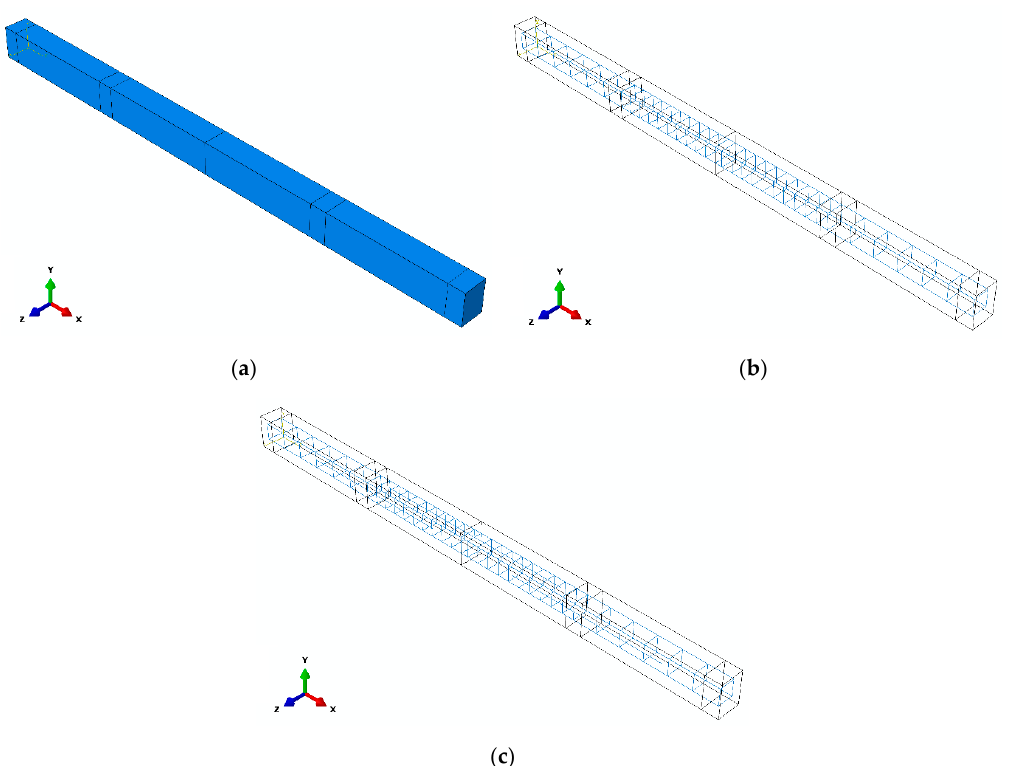
Figure 8. Model geometry in the software package Abaqus: ( a ) concrete beam; ( b ) reinforcement of Beams B − 1 and B − 2; ( c ) reinforcement of Beam B − 3.